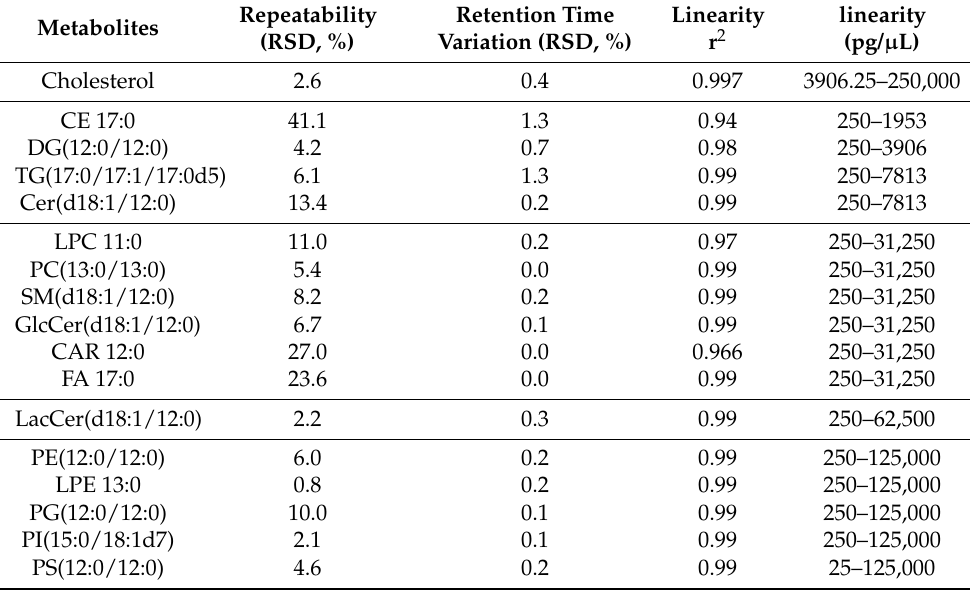
Table 2. Evaluation of the repeatability, retention time variation, and linearity (from 250 to 250,000 pg µ L − 1 ) of the 15 internal standards, representing the six lipid